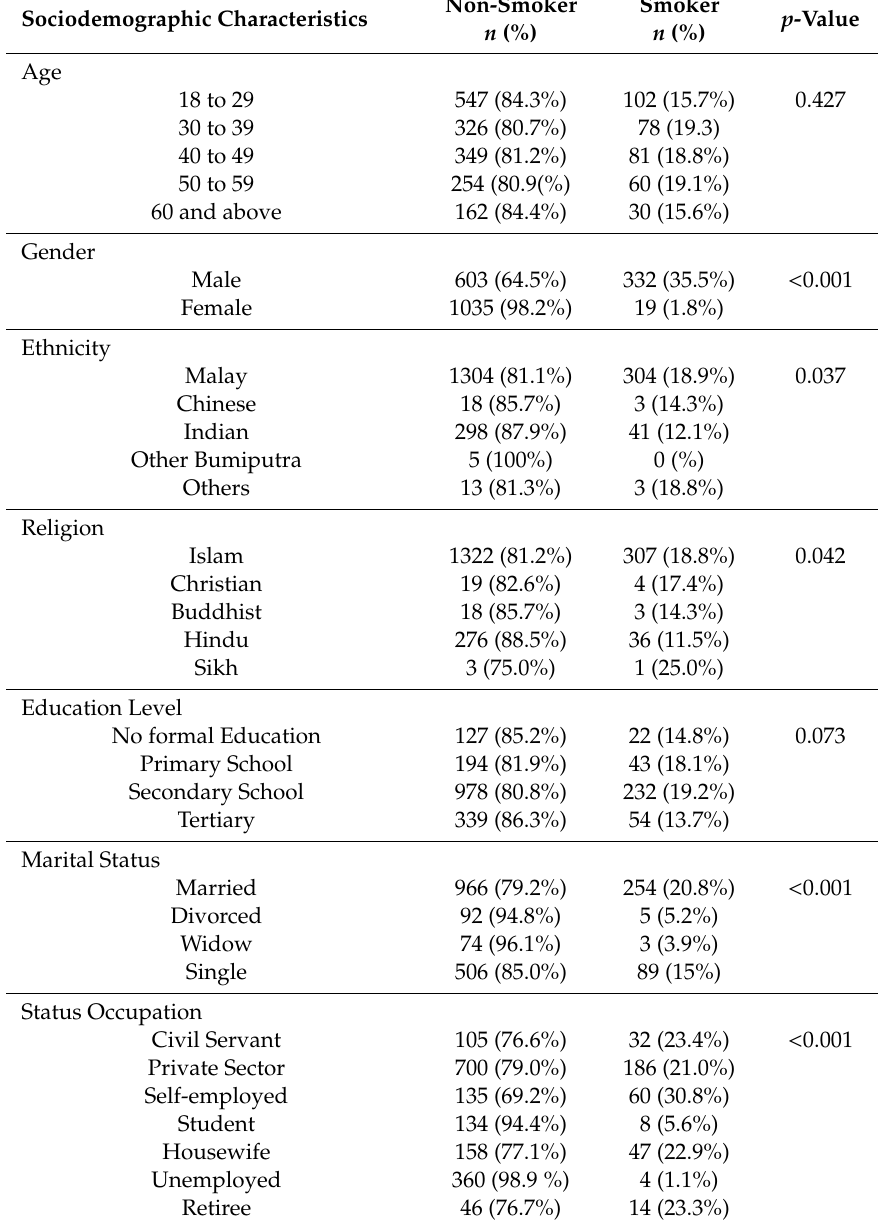
Table 1. Distribution of demographic